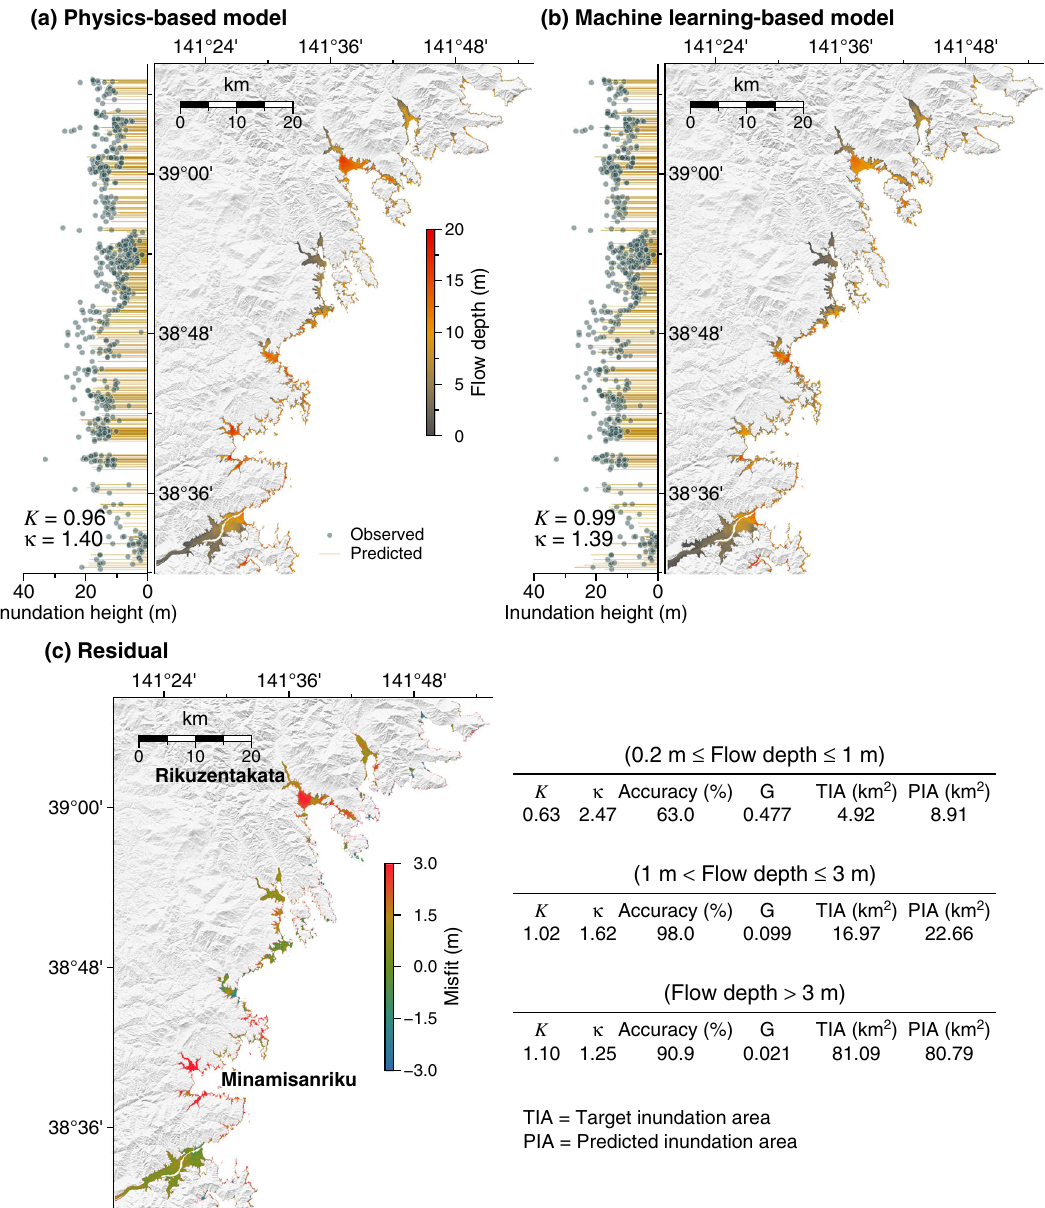
Fig. 7 | Prediction result and evaluation for the 2011 Tohoku-oki event. a Physics-based model. b Machine learning-based model. Inundation map of fl ow depths at locations of interest (right panel) and comparisons between observed